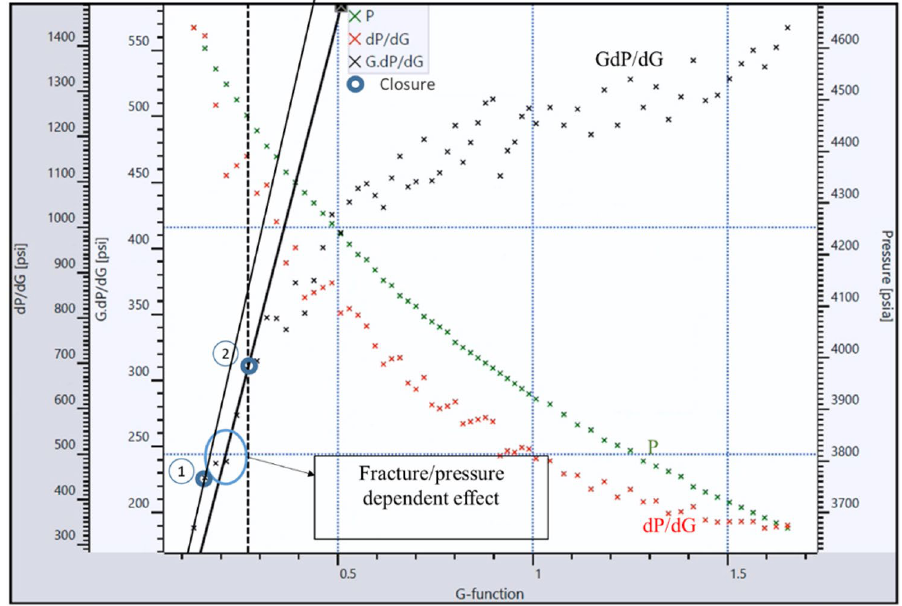
Fig. 17 A G-function plot for the DFIT test simulation with a single fracture striking at